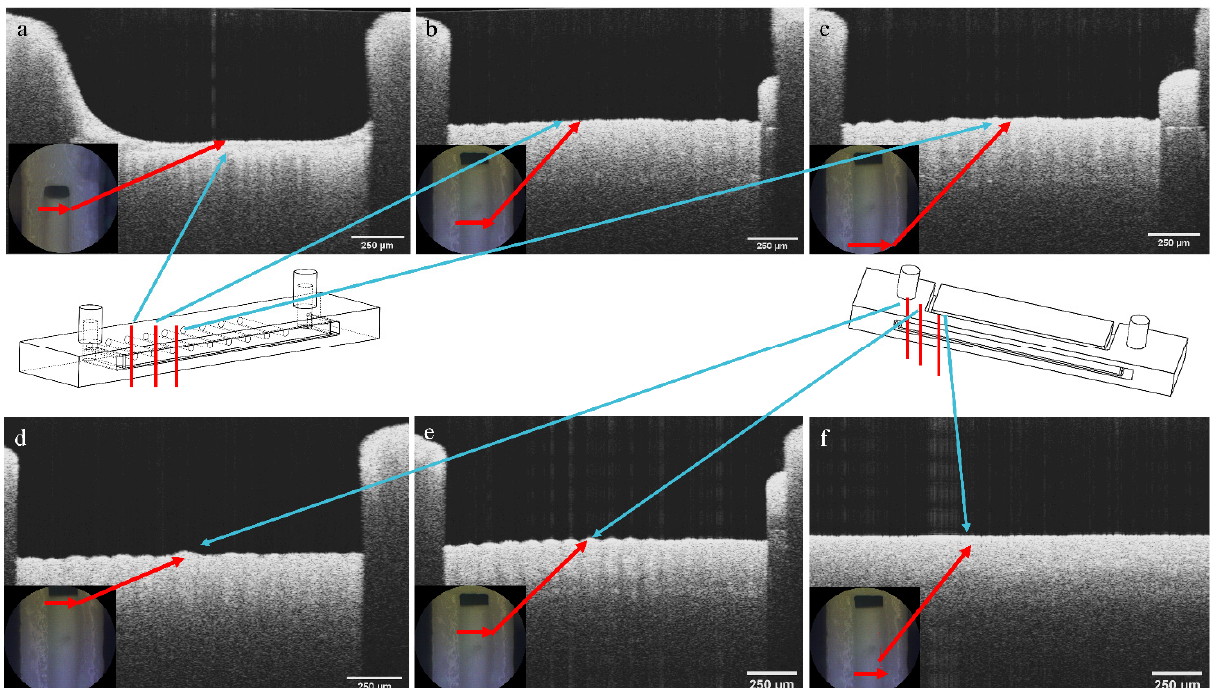
Figure 7. SD-OCT images of the ( a – c ) PPE side of the main channel; ( d – f ) PE side of the main channel of the microfluidic device, with marked distances at which the measuremets were carried out.